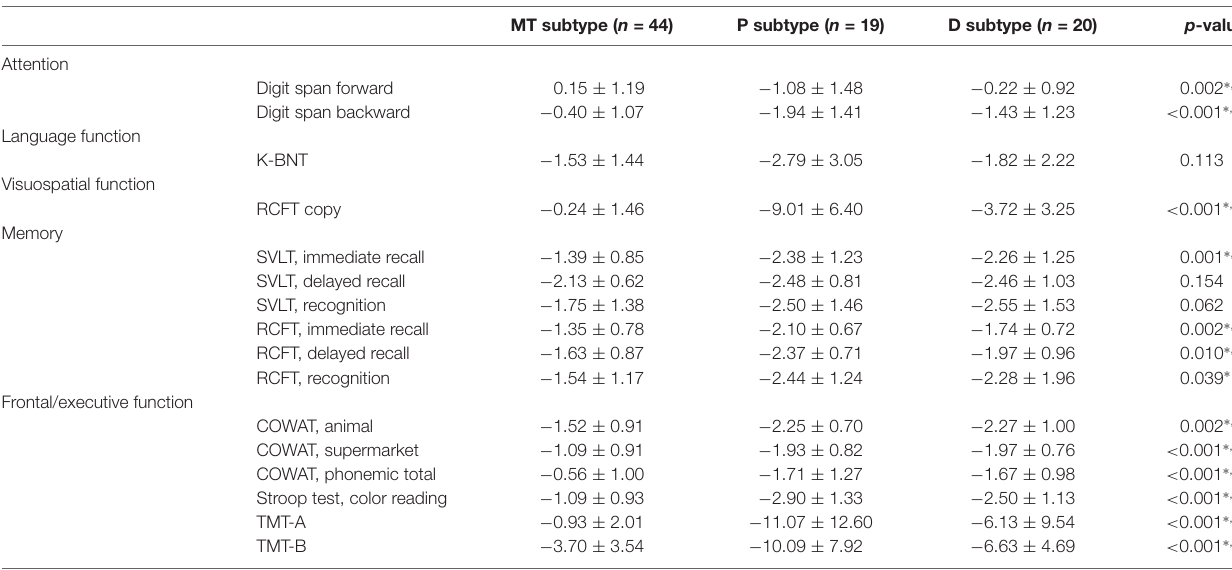
TABLE 2 | Neuropsychological test results for AD